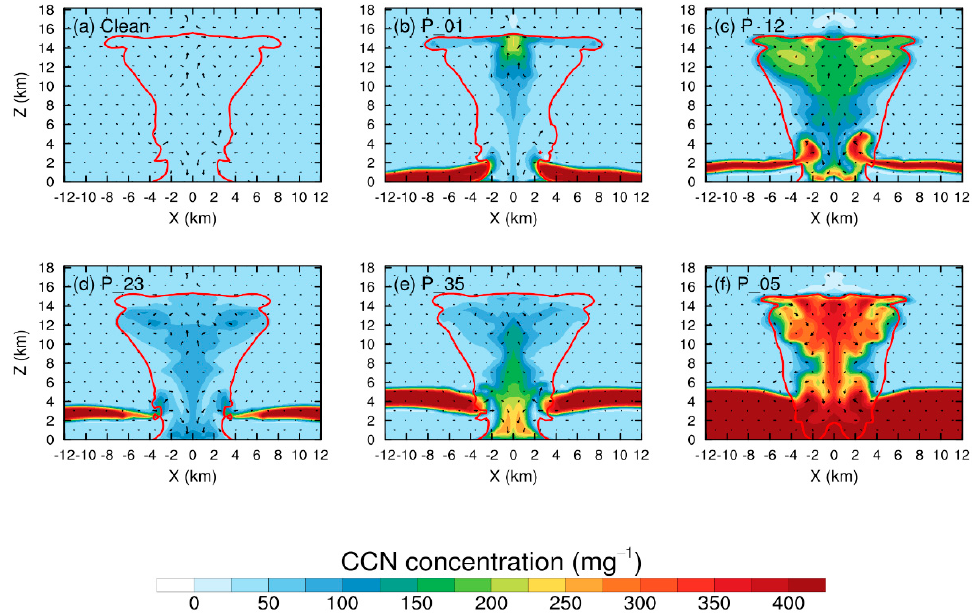
Figure 3. The same as Figure 2 but at 32 min in the ( a ) Clean, ( b ) P_01, ( c ) P_12, ( d ) P_23, ( e ) P_35 and ( f ) P_05 simulations respectively.